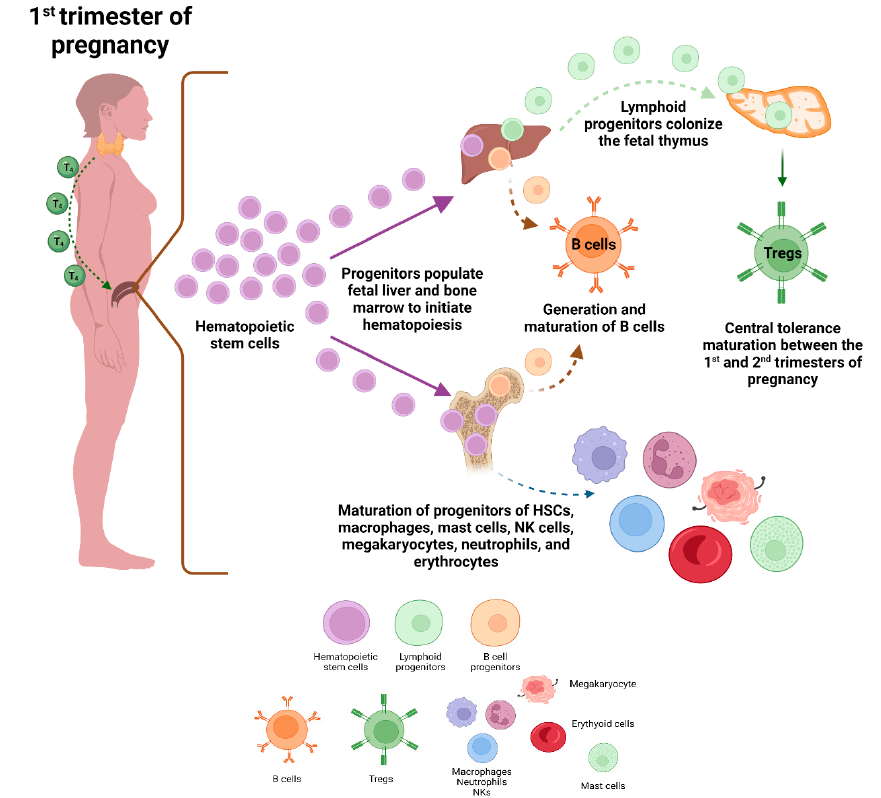
Figure 2. Fetal immune development. Placental hematopoietic stem cells populate the liver and bone marrow of the fetus, where hematopoiesis takes place. Lymphoid progenitors migrate and colonize the fetal thymus, where lymphocyte maturation and central tolerance occur. In parallel, hepatic progenitors also mature to form B cells during the first trimester. On the other hand, bone marrow progenitors will mainly develop into B cells, macrophages, mast cells, NK cells, neutrophils, megakaryocytes, and erythroid cells. As maternal thyroid hormones are pivotal for immune devel- opment during the first trimester, a thyroid deficiency during pregnancy will affect the develop- ment of the immune system of the progeny. Created with BioRender.com (accessed on 1 Jan 2022). 7.3. Maternal Glucocorticoids Related to Fetal Development Glucocorticoids (GCs) are essential steroid hormones for daily functioning in mam- mals. They are related to a several processes, such as metabolism, water and electrolyte balance, growth, cardiovascular function, immune response, reproduction, cognitive functions, and development [163]. GCs are mainly synthesized in the adrenal gland cor- tex, along with aldosterone and dehydro-epi-androsterone (DHEA), which are the pre- cursors of testosterone and estrogen. Adrenal GCs’ production is regulated by the hypo- thalamic–pituitary–adrenal (HPA) axis [164]. Under basal or unstressed conditions, GCs are released into the bloodstream in a circadian rhythm characterized by peak levels dur- ing the active phase (the morning in humans and at the beginning of nighttime in noctur- nal animals such as mice). On the other hand, under physiological conditions such as an immune response or emotional stress, the HPA axis increases its activity, releasing the corticotropin-releasing hormone (CRH) and arginine vasopressin (AVP) (from the hypo- thalamic paraventricular nucleus (PVN)), which binds to CRH-R1 and V1B receptors,